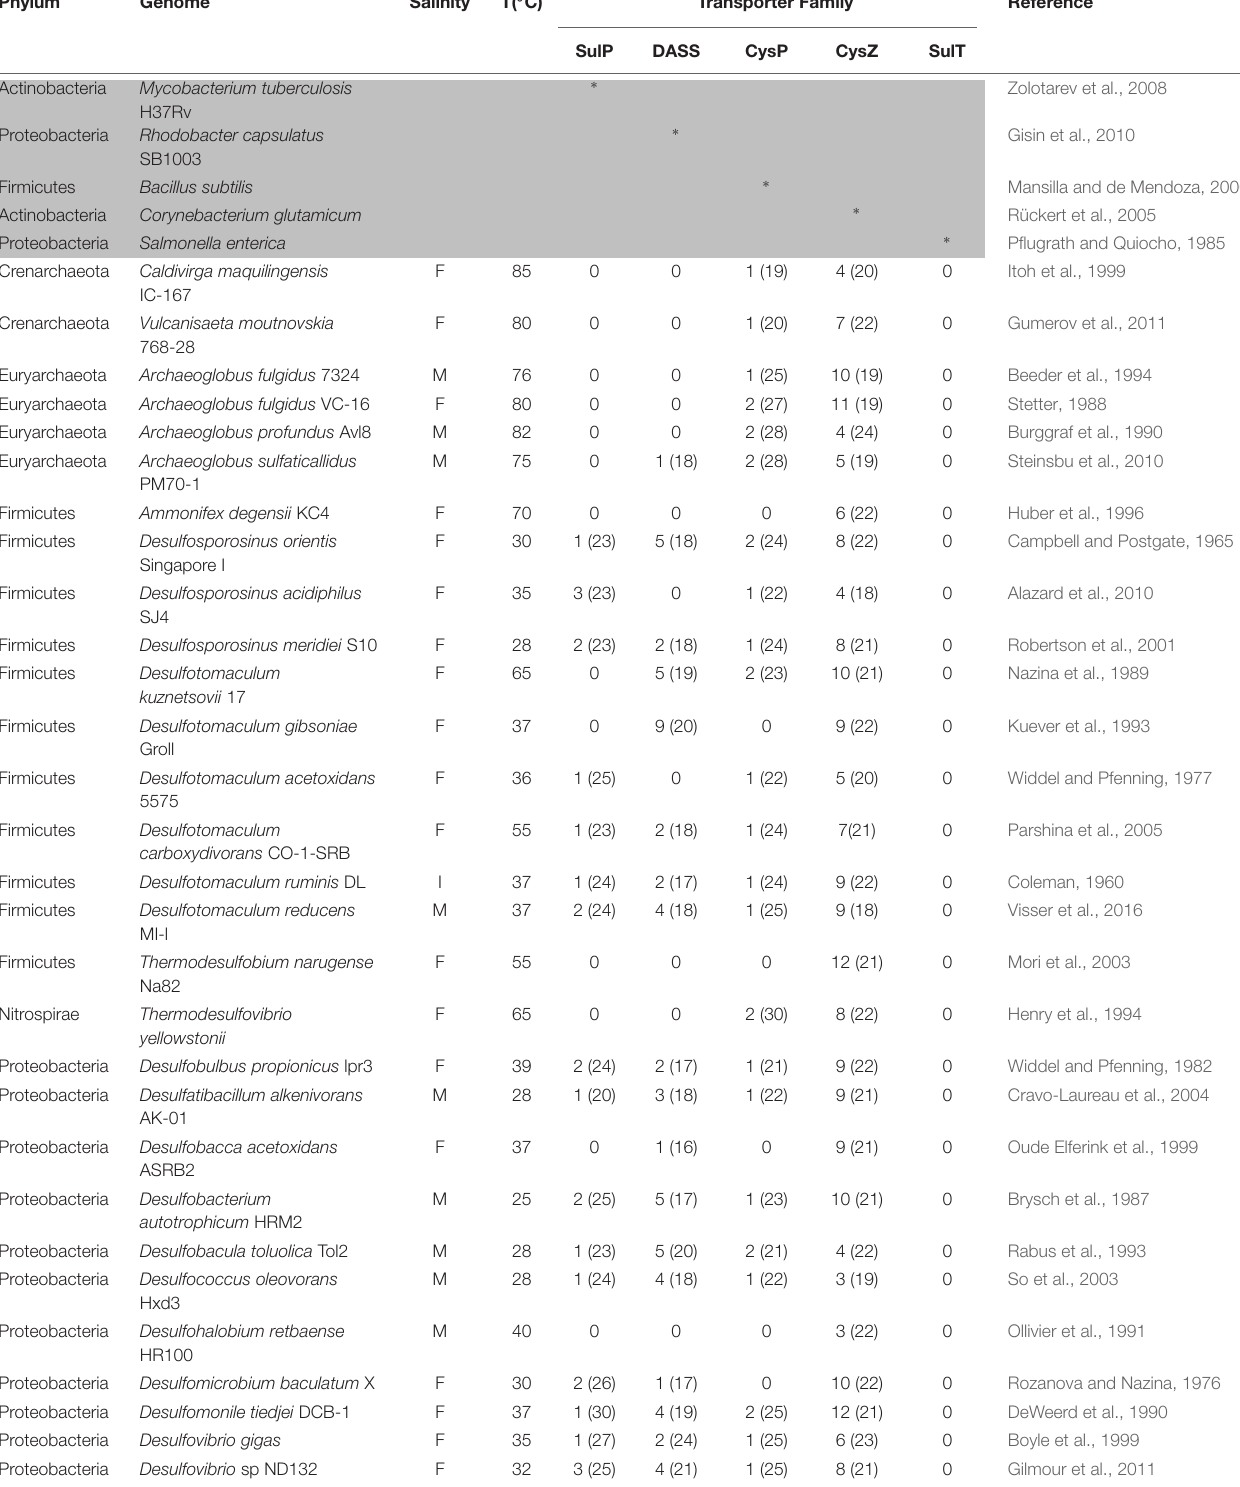
TABLE 1 | The number of putative sulfate transporter proteins present in the complete genomes of 44 SRMs for each transport protein family. Phylum